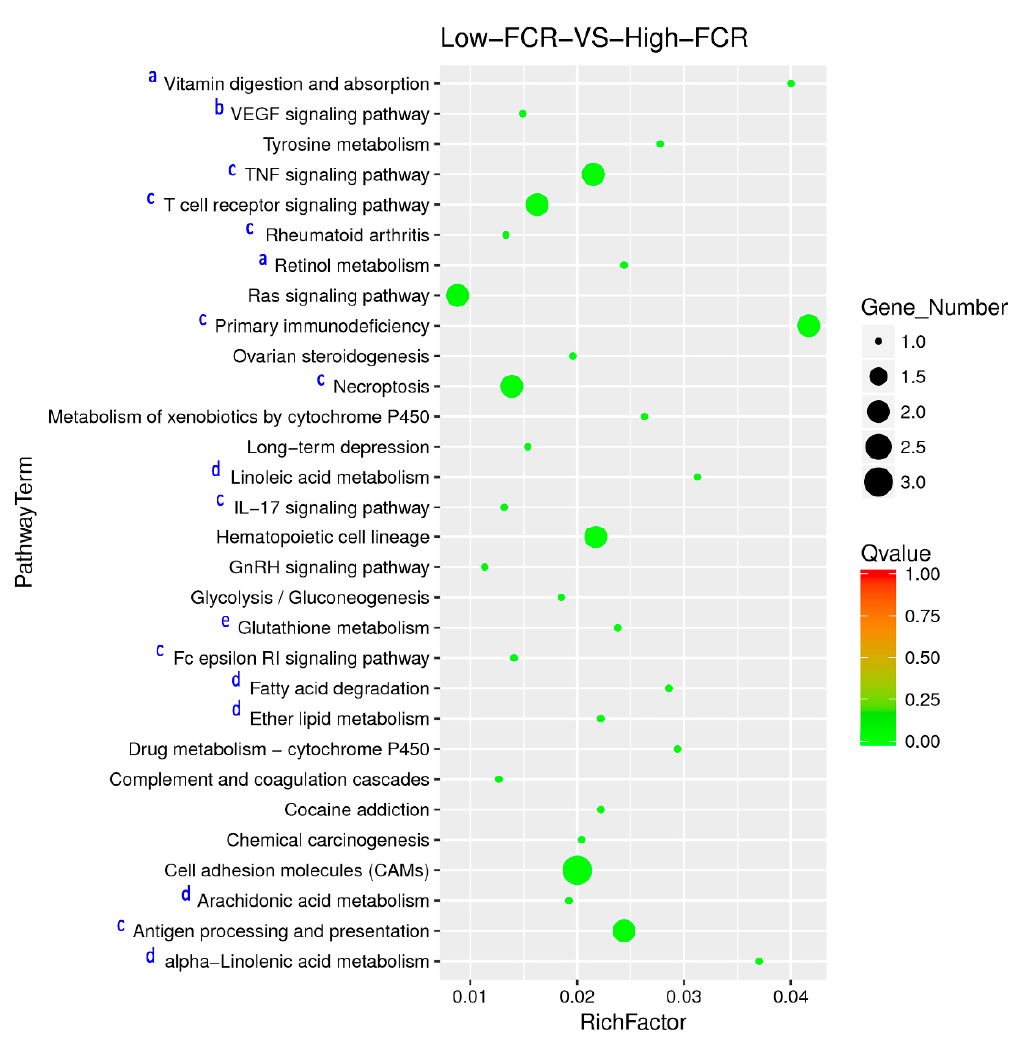
Figure 8. Scatter plot showing the top 30 of enriched KEGG pathways associated with difference in FCR. The size of the dots is positively correlated to the number of DEGs that belong to the pathway. The main pathways including vitamin metabolism (a), neuronal and cardiac maturation, development and growth (b), immune response (c), lipid metabolism (d) and glutathione metabolism (e) are indicated in the Y axis.